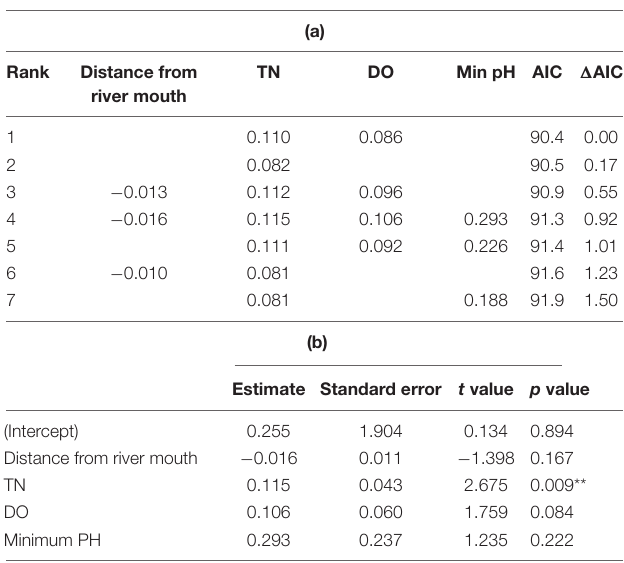
TABLE 3 | Summary of the GLMs with (cid:49) AIC < 2.